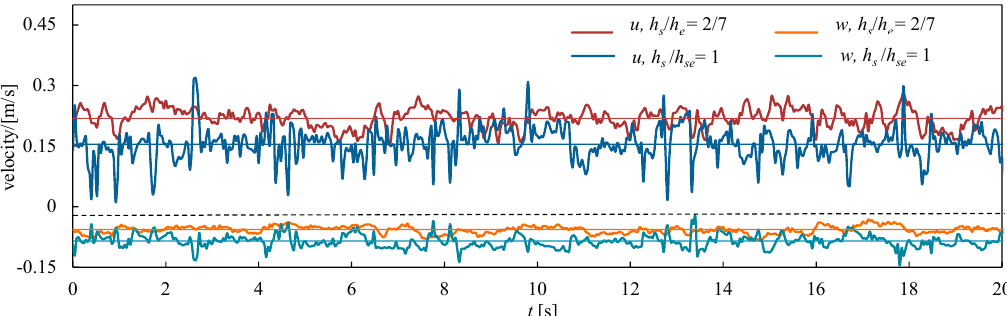
Figure 11. Time histories of instantaneous velocity for intermediate and equilibrium scour holes.